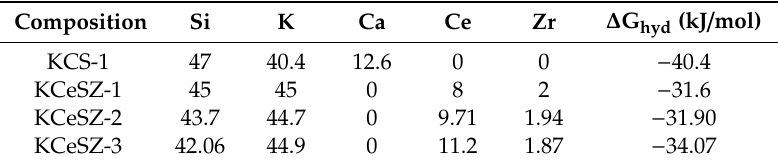
Table 3. Synthesized glass